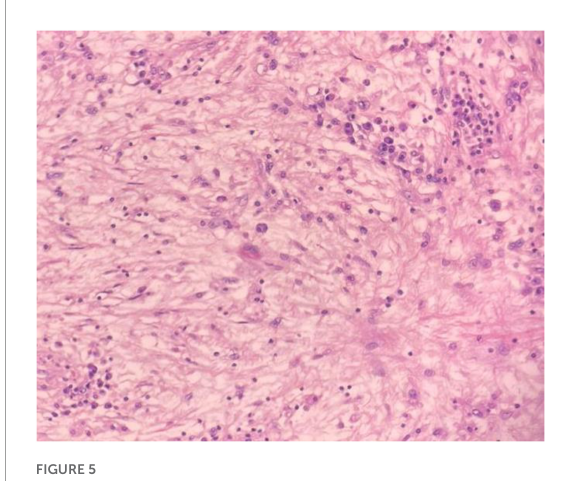
FIGURE5 Microscopic image of abundant chronic mononuclear and inflammatory cells, mostly lymphocytes, plasma cells, and histiocytes accompanied by eosinophils and scanty lymphoid aggregations,